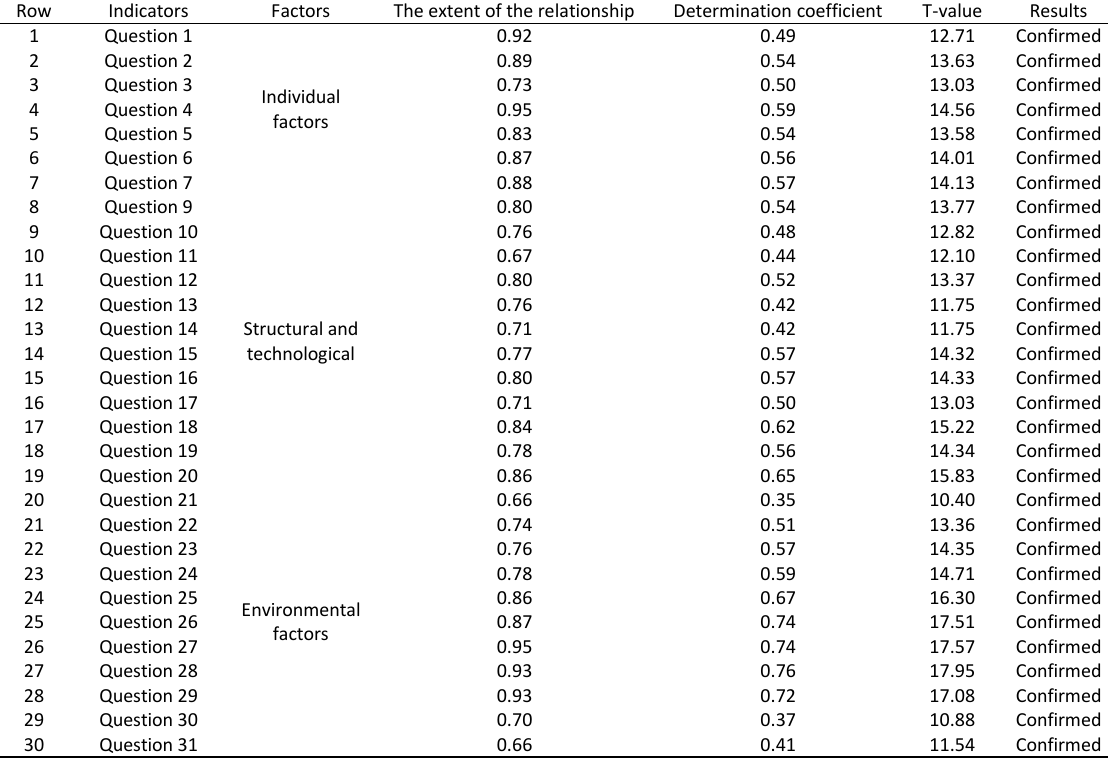
Table 4. Relationships of questions with components